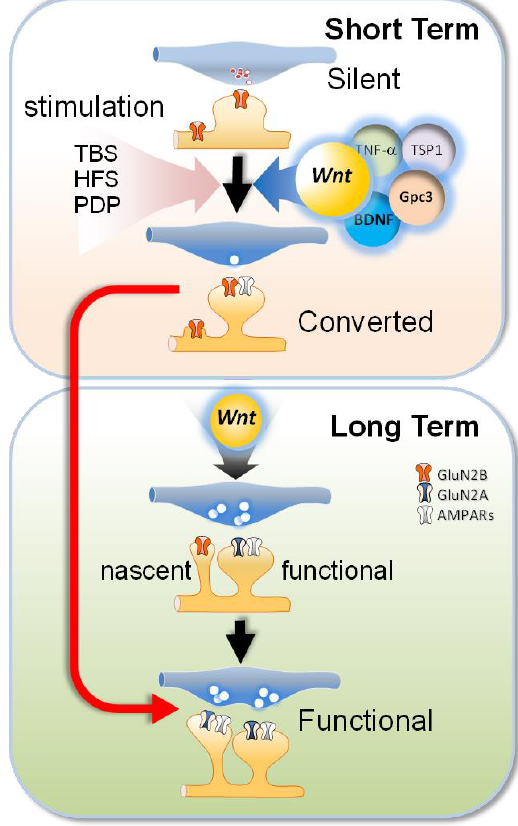
Figure 1. Synaptic formation and functional maturation of glutamatergic synapses. During synaptogenesis, Wnt agonists may thereby induce the birth of dendritic spines, promoting the trafficking of GluN2B-containing receptors to nascent synapses. The transformation of silent synapses (i.e., solely express GluN2B) into converted synapses can be triggered by several neuritogenic factors, including Wnt, Brain-derived neurotrophic factor (BDNF), Tumor necrosis factor α (TNF α ), glypicans (Gpc), and astrocyte-secreted thrombospondins (TSP). In converted synapses, Wnt agonists could promote the developmental switch, changing GluN2B-containing receptors to GluN2A-containing